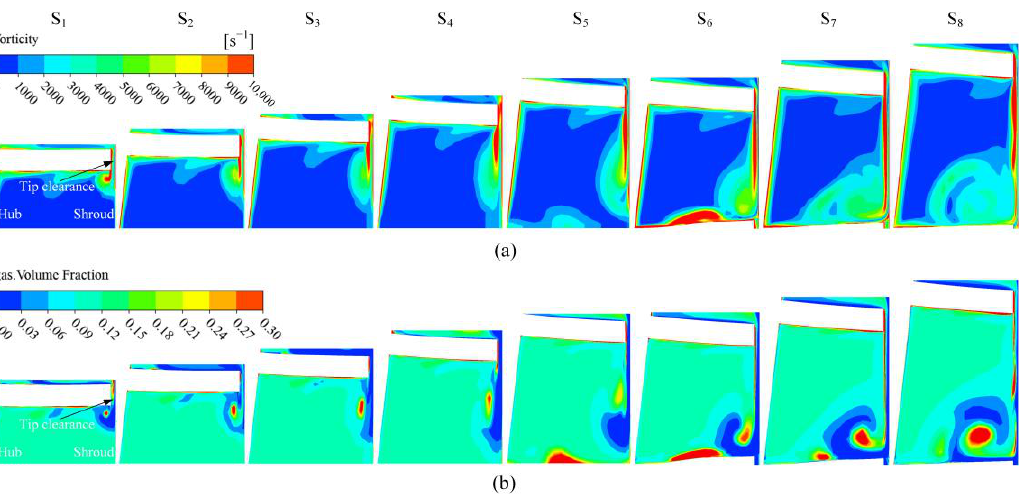
Figure 9. Vorticity and gas volume fraction on sections with IGVF of 10%.( a ) Vorticity and ( b ) gas volume fraction.